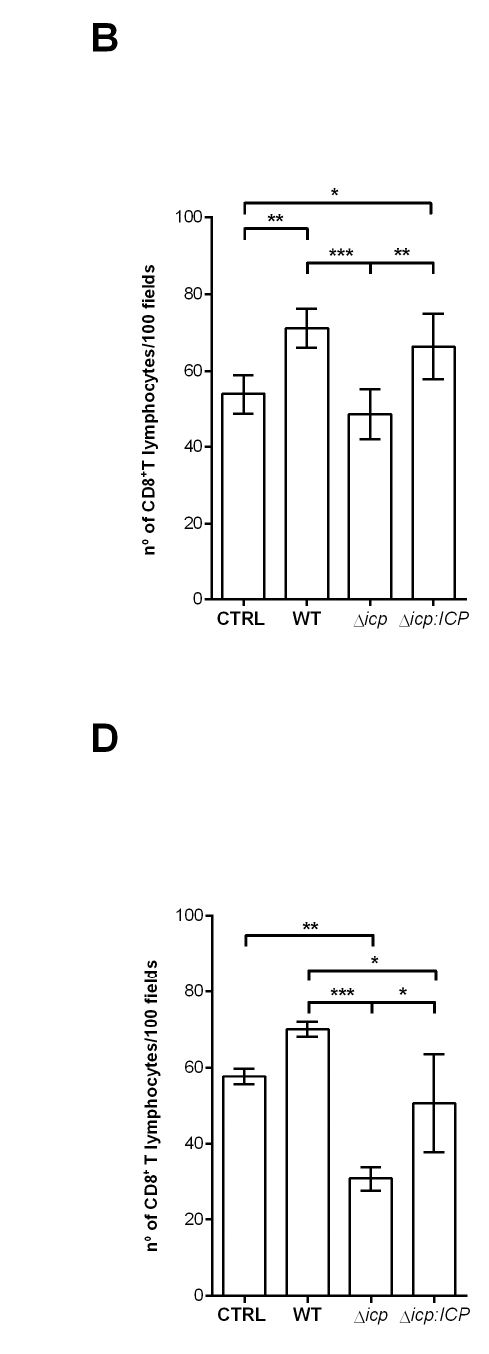
Figure 6. T. b. rhodesiense ∆ icp make HBMECs less susceptible to adhesion by T lymphocytes. Human BMECs (5 × 10 4 ) were seeded on glass coverslips and cultured for 3 days, after which BSF parasites of T. b. rhodesiense WT, ∆ icp , and ∆ icp:ICP were added at a 2:1 parasite:cell ratio for 18 h. CD4 + and CD8 + T cells (4 × 10 5 ) were bead-purified from human blood, and were either ( A , B ) non-activated or ( C , D ) activated in vitro with 5 µ g/mL phytohemagglutinin prior to addition to HBMECs. The cells were then co-cultivated for 2 h. CTRL refers to HBMECs cultivated with either activated or non-activated T cells only. Following this, cells were washed, fixed with 70% methanol and then Giemsa stained. The number of adhered T lymphocytes were determined by the counting of 100 HBMECs per coverslip under a light microscope. The experiments were performed in triplicate, three independent times, and data are shown as the mean ± SD of a representative experiment. Asterisks indicate statistical significance at p < 0.05 (*), p < 0.01 (**), and p < 0.001 (***) as assessed by one-way ANOVA with Tukey’s post hoc